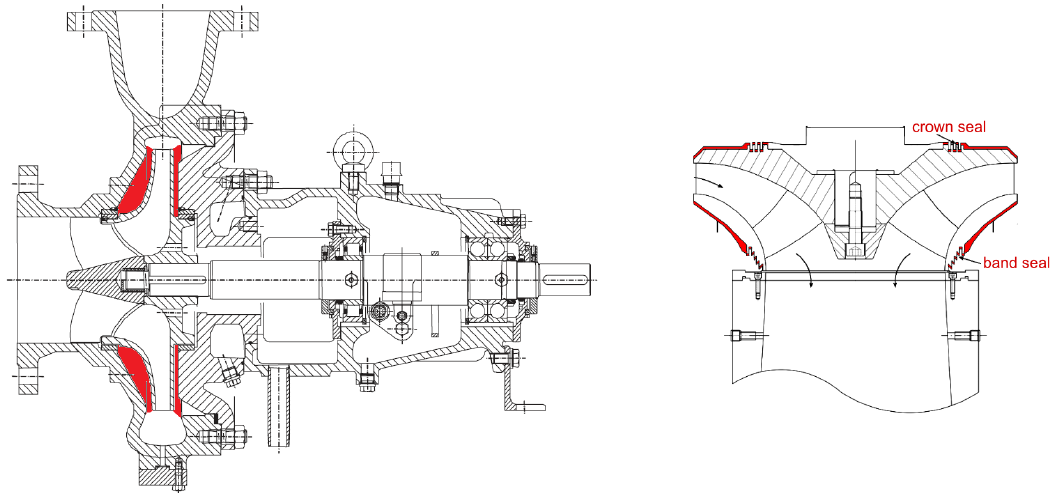
Figure 1. Sidewall gaps in a pump [8] and turbine